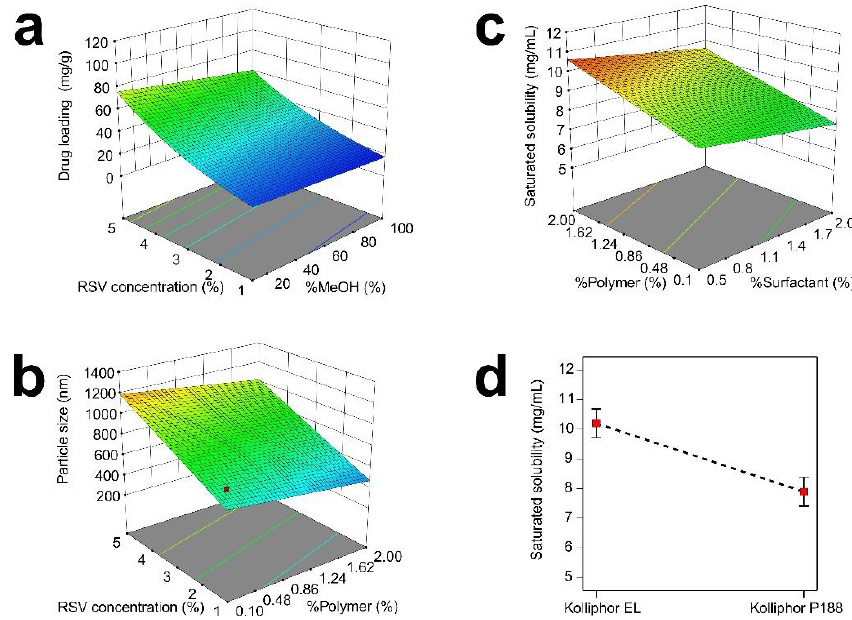
Figure 4. Contour plot of drug loading ( a ), particle size ( b ), and saturated solubility ( c ); and single plot of type of surfactant ( d ). plot of type of surfactant ( d